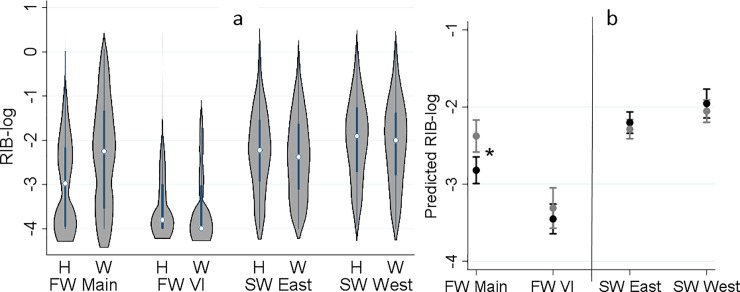
Distribution of log10-relative infection burden (RIB) of all detected infectious agents in 2,655 juvenile Coho salmon by sampling region and origin (H: hatchery and W: wild) on left side, and the interaction plot for the results of the linear regression model, indicating predicted log10-RIB (Y axis) by sampling region and origin (black: hatchery and grey: wild) on right side. Sampling regions: 1) freshwater-Mainland; 2) freshwater-Vancouver Island (VI); 3) saltwater-east coast of VI; and 4) saltwater-west coast of VI. *Statistical comparisons (Bonferroni groups) for predicted RIB-log between hatchery and wild were only significant in freshwater-Mainland (P < 0.001).